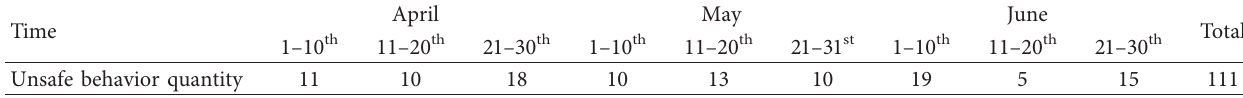
Table 11: Fitted values of violating labor